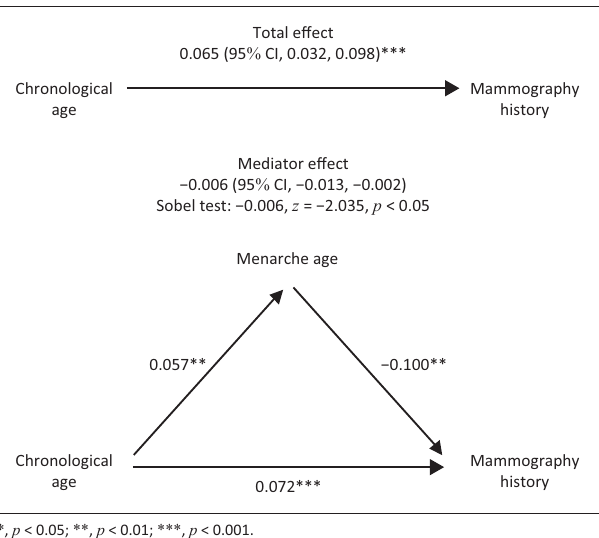
FIGURE 2: The relationships between chronological age, menarche age and mammography history.